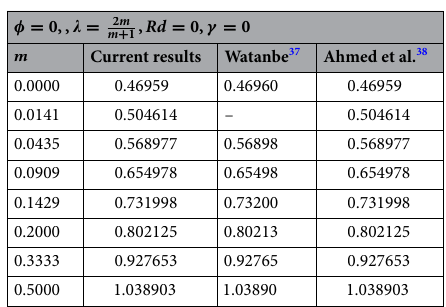
Table 2. Validation of the study for F ′′ ( 0 ) under certain conditions on the flow